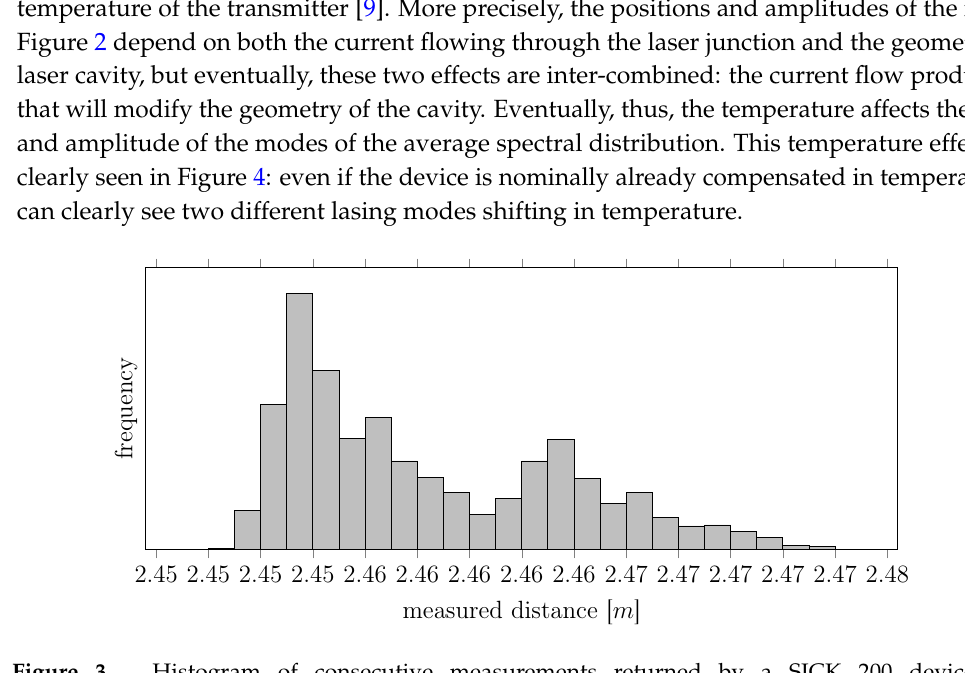
Figure 3. Histogram of consecutive measurements returned by a SICK 200 device in thermodynamical and electrical equilibrium pointing at a fixed object and in a controlled environment.